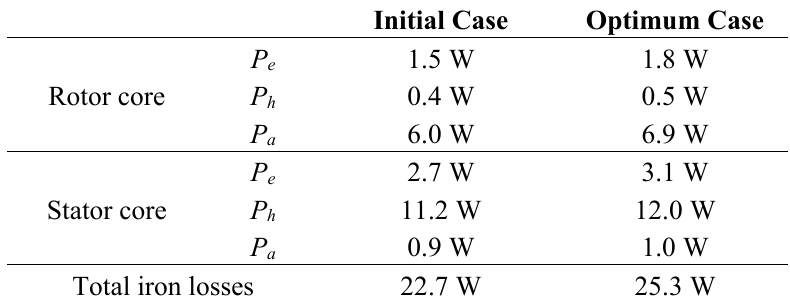
Table 7. Comparison of iron losses between initial case and optimum case at rated